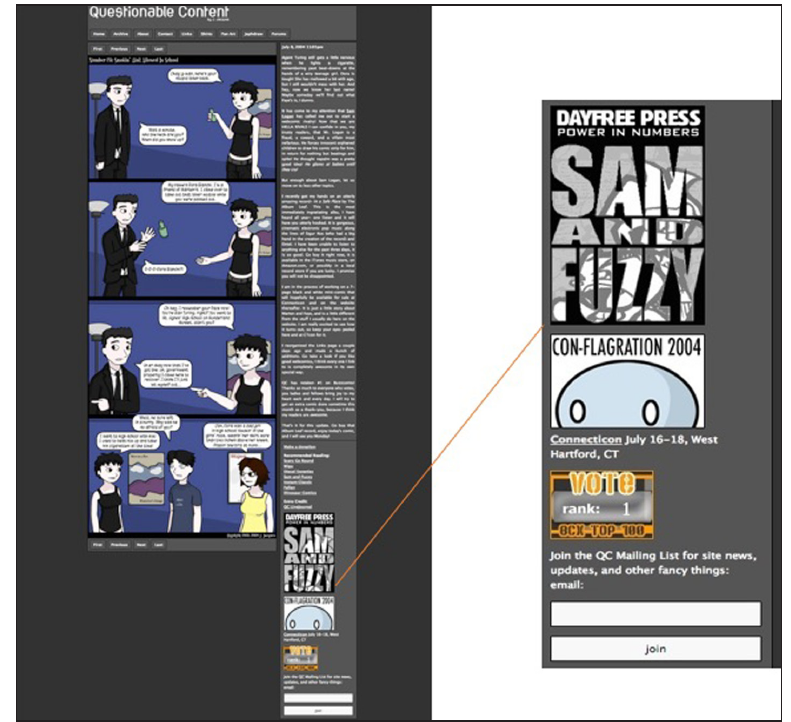
Figure 1: Jacques, J (2004) Smoking Ain’t Allowed in School Questionable Content . First appeared in July 2004 as shown. Comic available at https://www.questiona- blecontent.net/view.php?comic=151; Ad accessed via the WayBack Machine and no longer